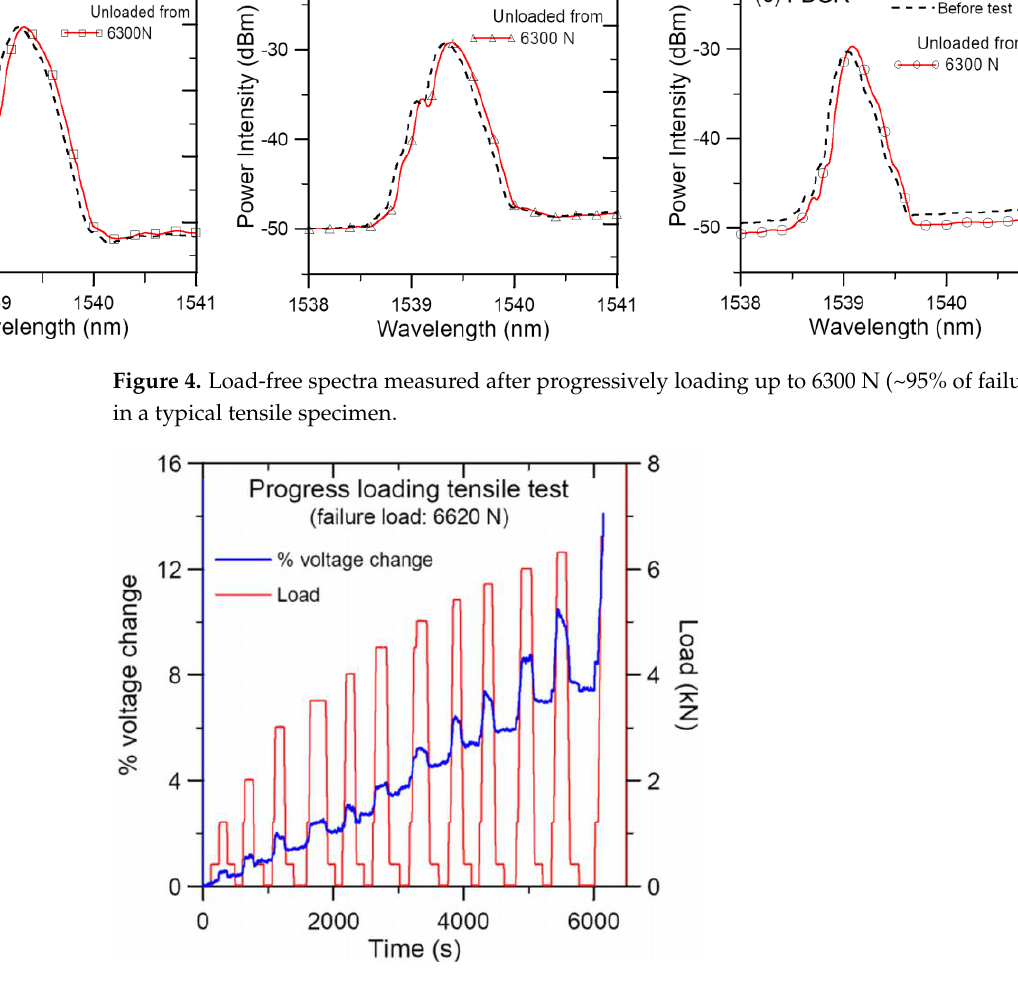
Figure 5. Percentage voltage change on progressive loading up and unloading.